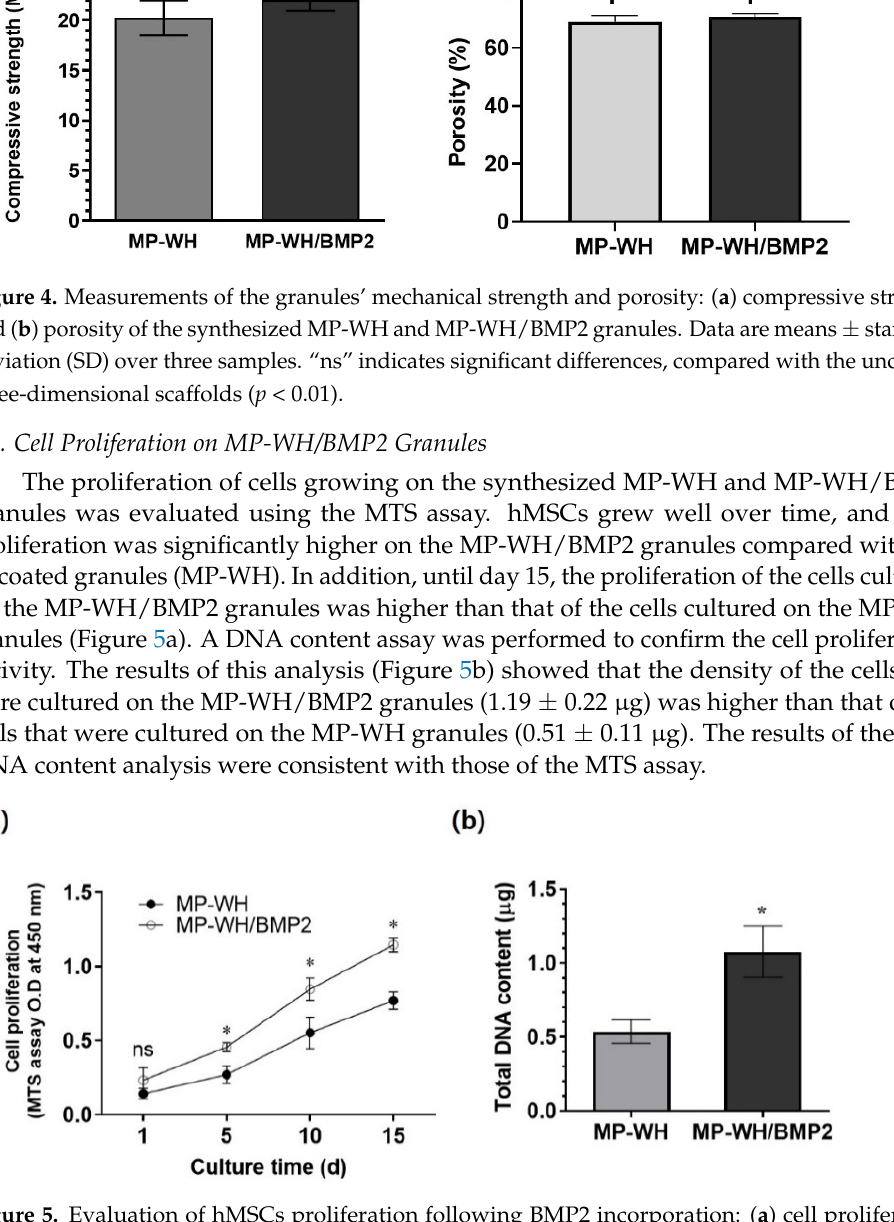
Figure 5. Evaluation of hMSCs proliferation following BMP2 incorporation: ( a ) cell proliferation evaluated using the MTS assay at 1, 5, 10, and 15 days; ( b ) to confirm the cell proliferation, a DNA content assay is performed five days after the seeding. The presented data are means ± standard deviation (SD) of three samples. * p < 0.05 indicates significant differences with respect to the uncoated scaffolds. ‘ns’ indicates not significant.